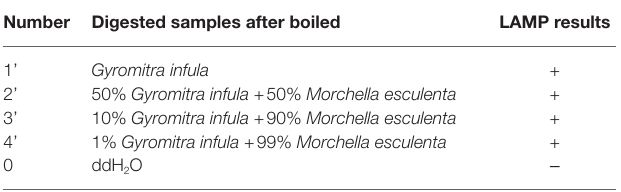
TABLE 7 | Applicability results of LAMP assay with digested mushrooms after boiled. Number Digested samples after boiled LAMP results